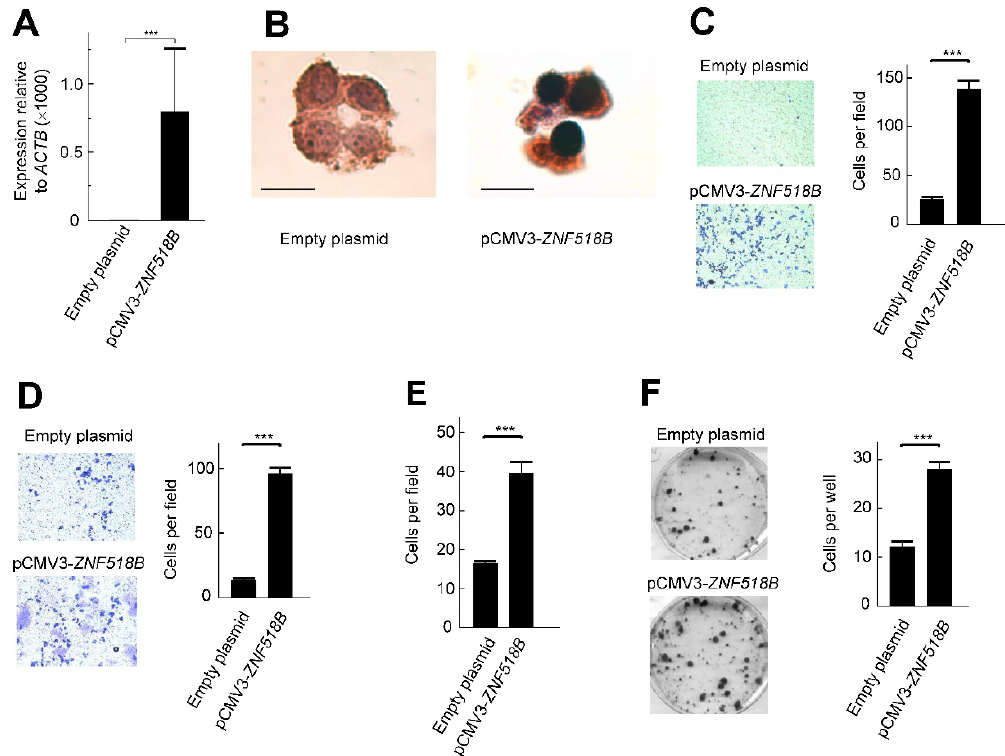
Figure 2. Overexpression of ZNF518B in RKO cells shows the nuclear location of ZNF518B and an increase in cell migra- tion, invasiveness and adhesion to type I collagen. The cells were transfected with pCMV3- ZNF518B, or with the empty plasmid. ( A ) RT-qPCR analysis of the overexpression of ZNF518B in RKO cells. ( B ) Immunocytochemical analysis; size bar, 20 µ m. ( C ) Transwell migration assay. A photograph of representative plates is shown (left) and the counting values (six different areas) were averaged (right). ( D ) Effects of overexpression of ZNF518B on the invasiveness of RKO cells. The assay was carried out as in (C), but through a Matrigel layer. ( E ) Effects of overexpression of ZNF518B on the adhesion of RKO cells to type I collagen-coated plates. The total number of cells was counted as in (C). ( F ) Colony formation assays carried out in six-well plates as described under Materials and Methods. Two independent experiments (each one with three independent transfections) were done with RKO cells. The photograph of representative plates and the averaged quantification of the number of colonies in each of the three wells are given. Statistical analyses were carried out by Stu- dent’s t-test. ***, p < 0.001.